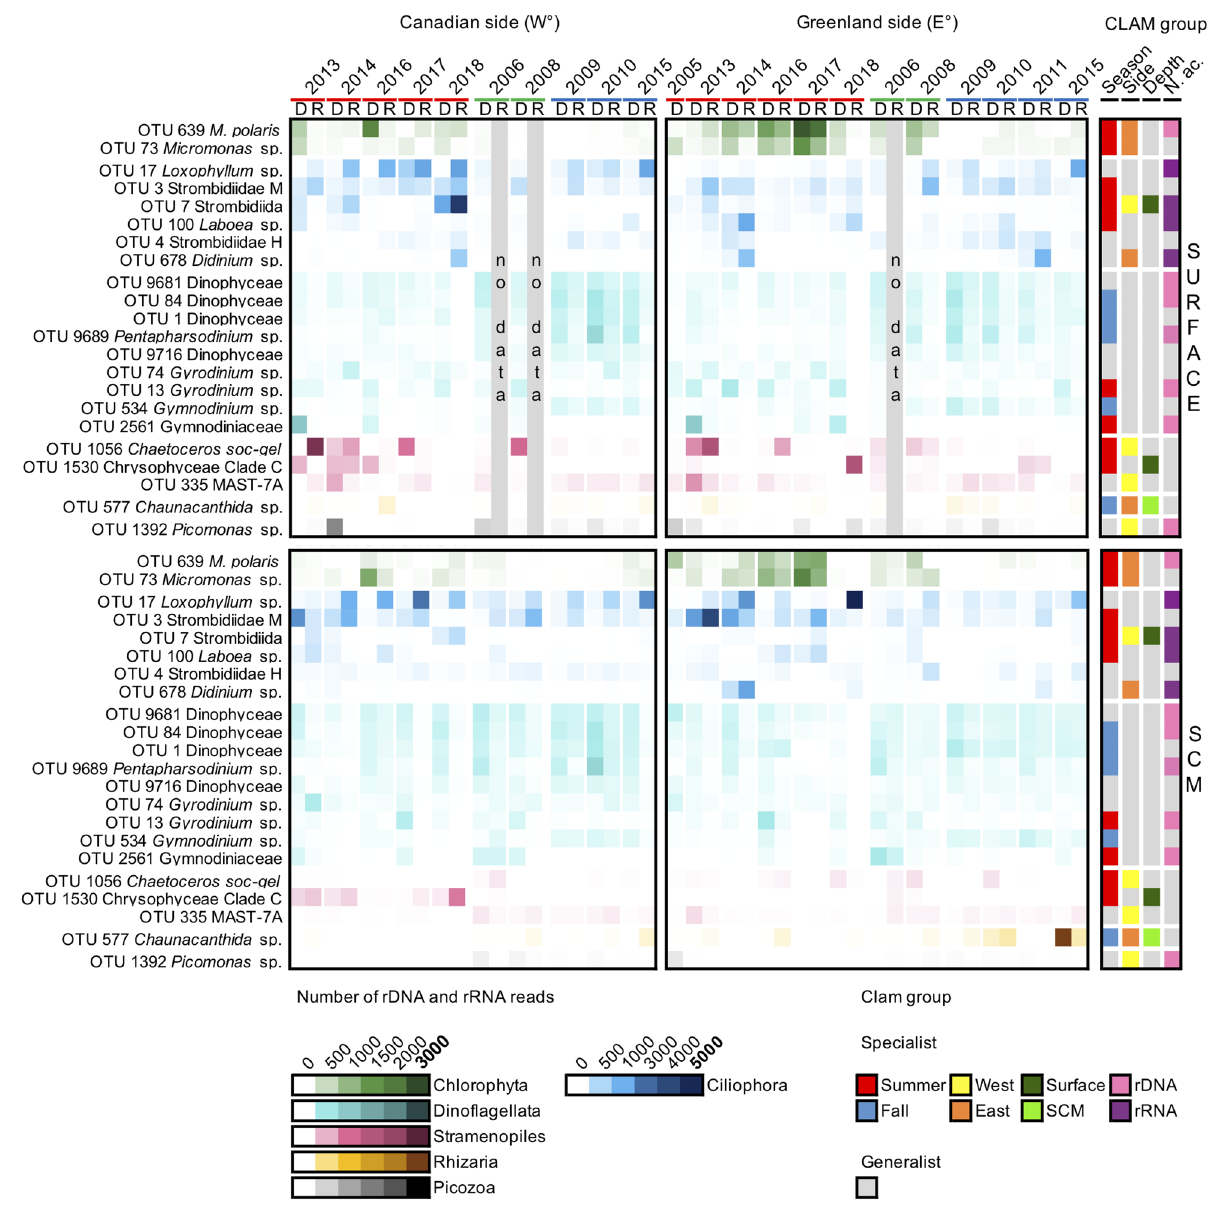
Figure 6. Proportion of reads from the 22 “top” OTUs defined as having reads accounting for > 0.5% of the entire community. Samples are ordered chronologically for each season (July–August: 2005, 2013–2014, 2016–2018; September: 2006 and 2008; October: 2009–2011 and 2015). The heatmap shows the rRNA (R) and rDNA (D) library results (upper axis). Taxa are ordered and color coded by major high-level classification (approximately equivalent to phyla in botanical nomenclature): from most to least abundant in terms of reads within the phyla (see Fig. 7 for identification of the OTUs). The color intensity in the heatmap reflects the number of reads of each taxon with darker intensities indicating higher read counts, note the different scale for Ciliophora. Based on the results of CLAM test (Fig. 5; Supplementary Figs. S5, S6 and S7), the corner right bars indicate specialist taxa. Color coded for specificity to a season, a region, a depth or to nucleic acid source. Grey in all bars indicate non-specialist taxa for the